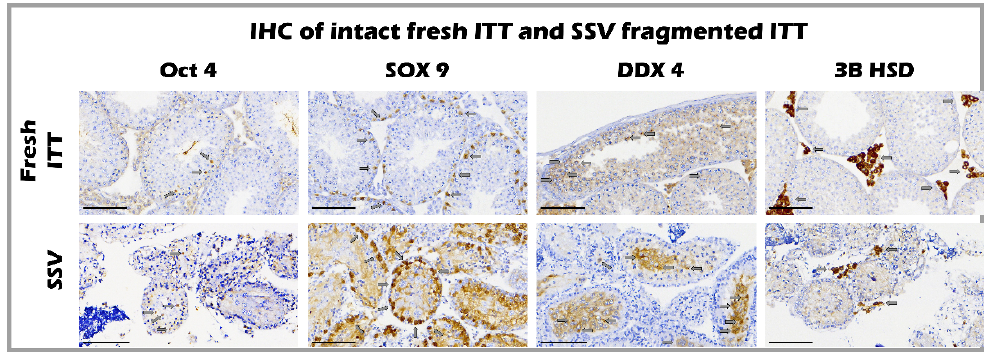
Figure 5. Expression of cell markers including Oct4, Sox-9, 3 β -HSD, and DDX4 showed an intact ultrastructure containing undifferentiated spermatogonia, Sertoli cells, Leydig cells, and germ cells (arrow), respectively, in both fresh control and SSV group, bar = 100 µm.